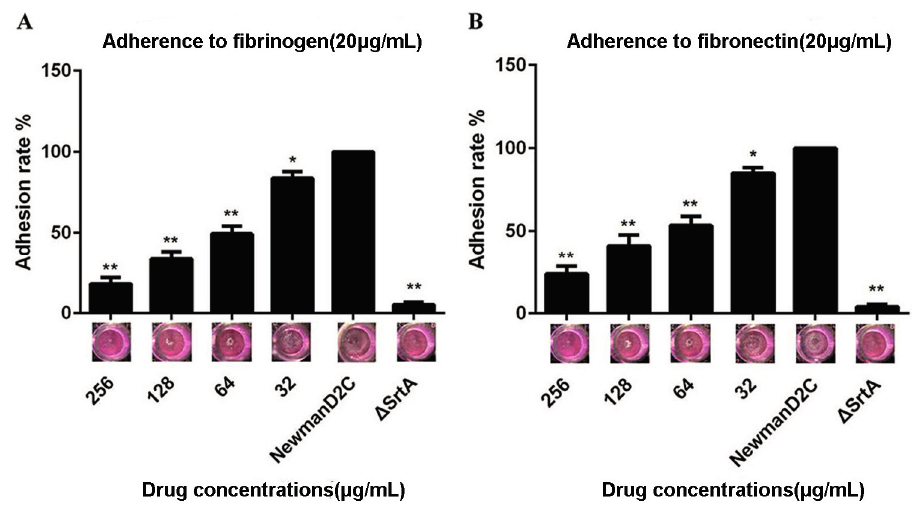
Figure 2. QEN inhibits the adherence of S. aureus to fibrinogen and fibronectin. Bacteria treated with the indicated concentrations of QEN were incubated in fibrinogen- or fibronectin-coated 96-well plates for 2 h at 37 °C, and the adhesion of S. aureus to fibrinogen ( A ) and fibronectin ( B ) was measured. * p < 0.05 and ** p <